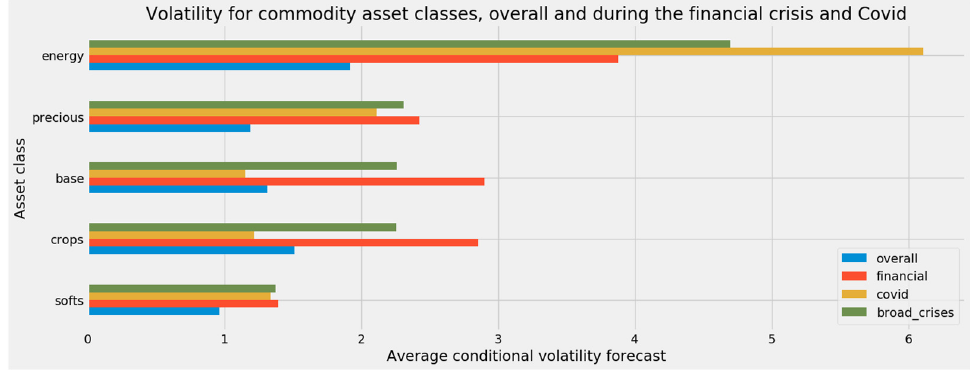
Figure 43. Volatility for commodity asset classes, overall and during the financial crisis of 2008–2009 and the COVID-19 pandemic.